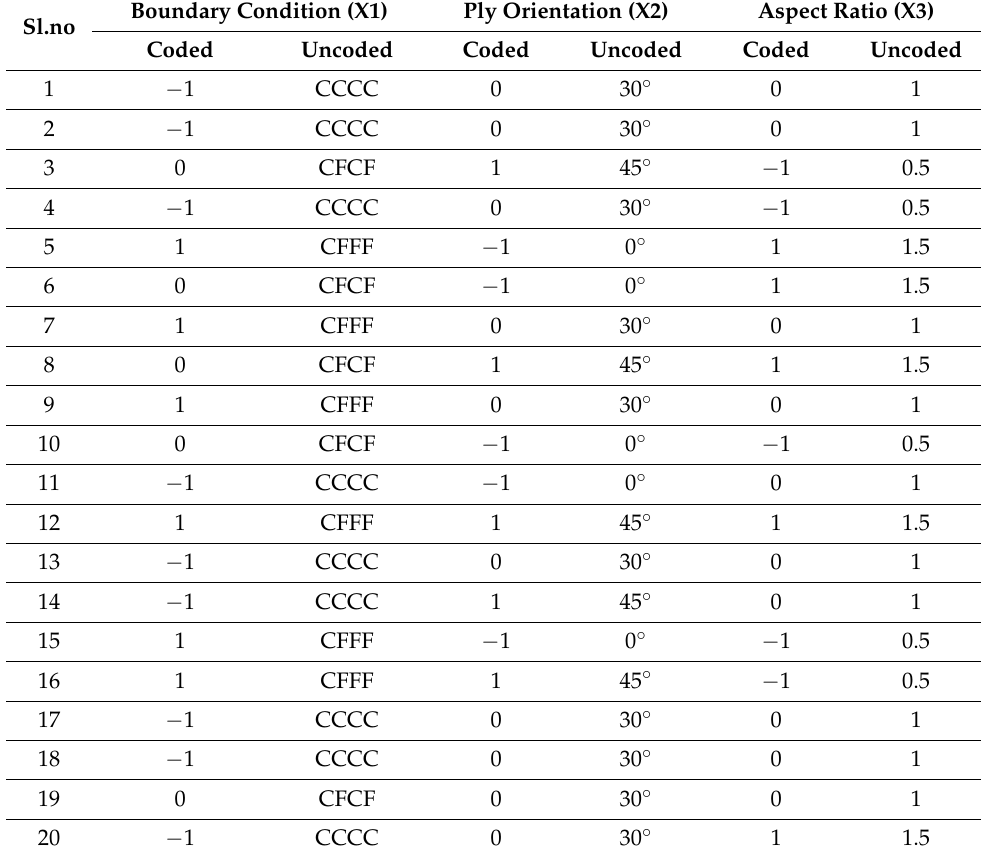
Table 2. Various combinations used for vibration